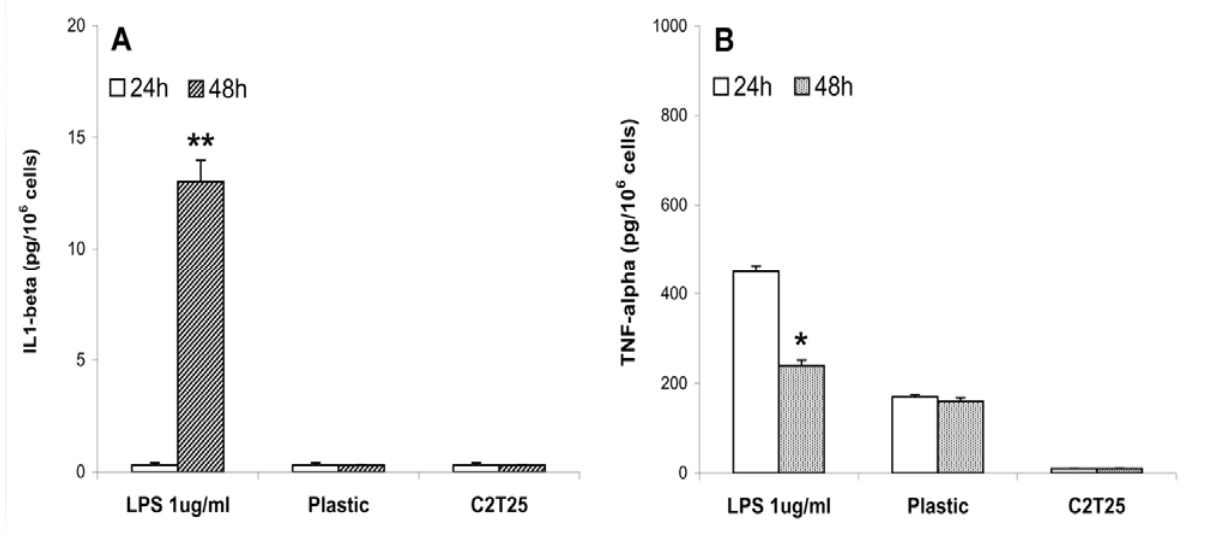
Figure 7. IL1-beta (A) and TNF-alfa (B) production by J111 cells grown for 24 and 48 hours on plastic and on the collagen membrane C2T25. Response to LPS was taken as a positive control. Data are expressed as mean values ± SD of four replicates. *p<0.05; **p<0.01 48 vs 24